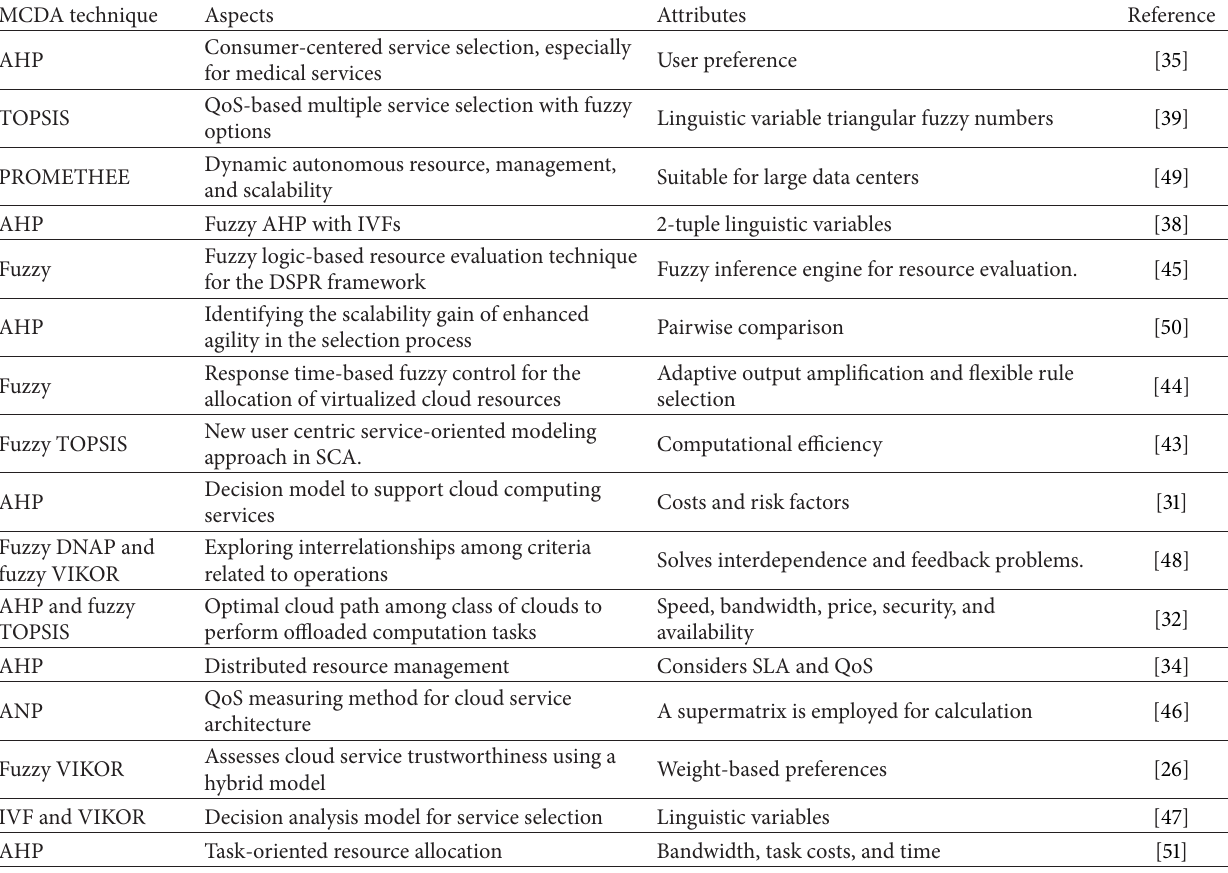
Table 2: Summary of different applied multicriteria methods for cloud service